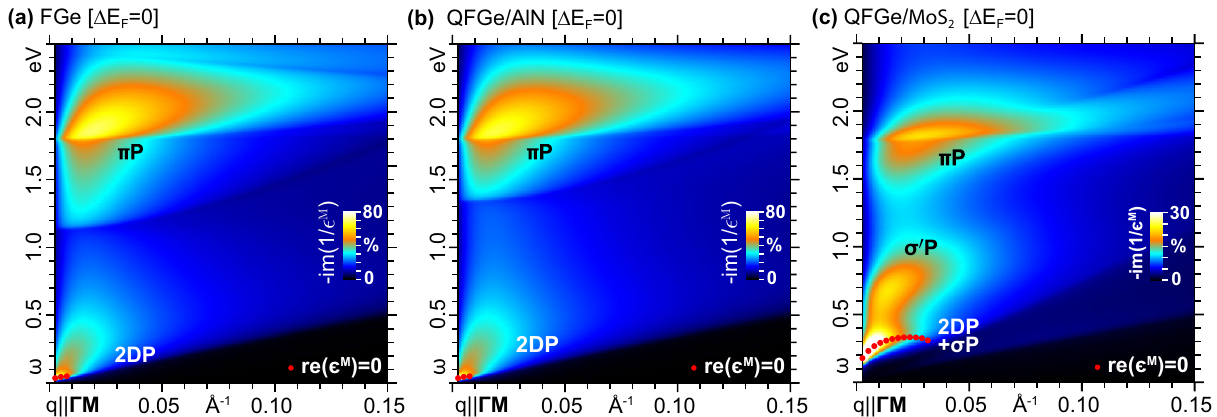
Figure 5. Intrinsic loss functions (in arb. units) of ( a ) FGe, ( b ) QFGe on AlN and ( c ) QFGe on MoS 2 , displayed 1 Ŵ M . The color scale is normalized to the maximum as density maps vs ω< 2.5 eV and q < 0.15Å − with q (cid:31) intensity of the ω< 0.4 eV mode, with the red dots labeling the undamped plasmon resonances. The dominant intraband (2DP, σ P) and interband ( σ ′ P, π P) modes are highlighted as in Fig.